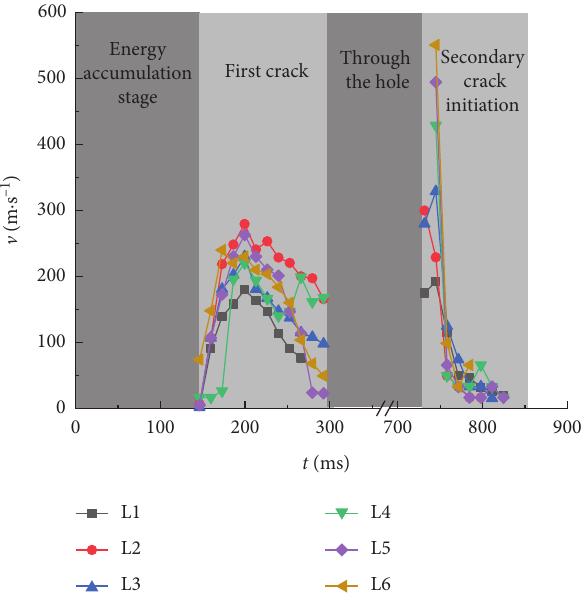
Figure 6: L1–L6 crack growth rate versus time curve. Figure 7: Stress intensity factor changes of specimens L1–L6 with